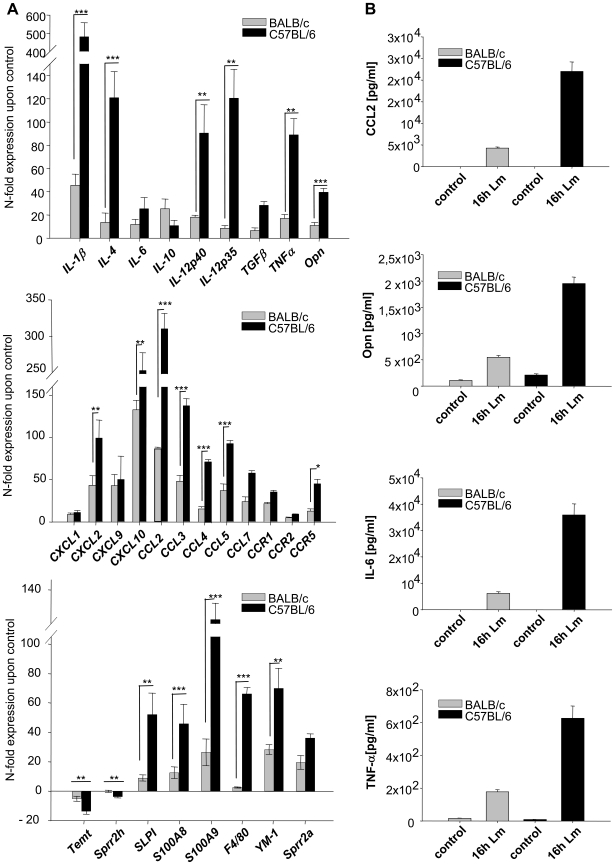
Analysis of gene and protein expression in L. major infected skin.
A) RT-PCR Analysis of gene expression in 16 h L. major infected skin. The PCR data were normalized to GAPDH expression and mean N-fold regulation and SEM in comparison to PBS injected controls was calculated (n = 3). Grey bars: Regulation in BALB/c mice; Black bars: Regulation in C57BL/6 mice. * = P<0.05, ** = P<0.01, *** = P<0,001 for differences between C57BL/6 and BALB/c mice, Student's t-test. B) Protein secretion in L. major infected skin. Soluble CCL2, Opn, TNFα (16h after infection) and IL-6 (8h after infection) protein was measured in infected foots as described in Materials and Methods. Striped grey bars: Mean and SE in BALB/c mice; Black bars: Mean and SE C57BL/6 mice. The experiment was performed three times with similar results.